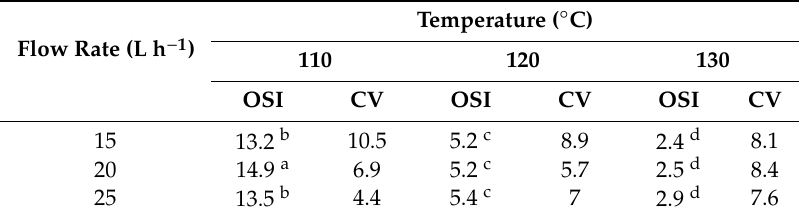
Table 1. Kernel oxidative stability index (OSI) expressed in hours; and coe ffi cient of variance (CV) of the treatment combinations at di ff erent airflows and